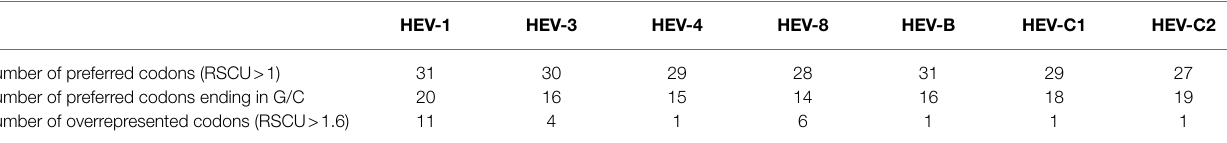
TABLE 3 | Number of preferred codons in the seven HEV